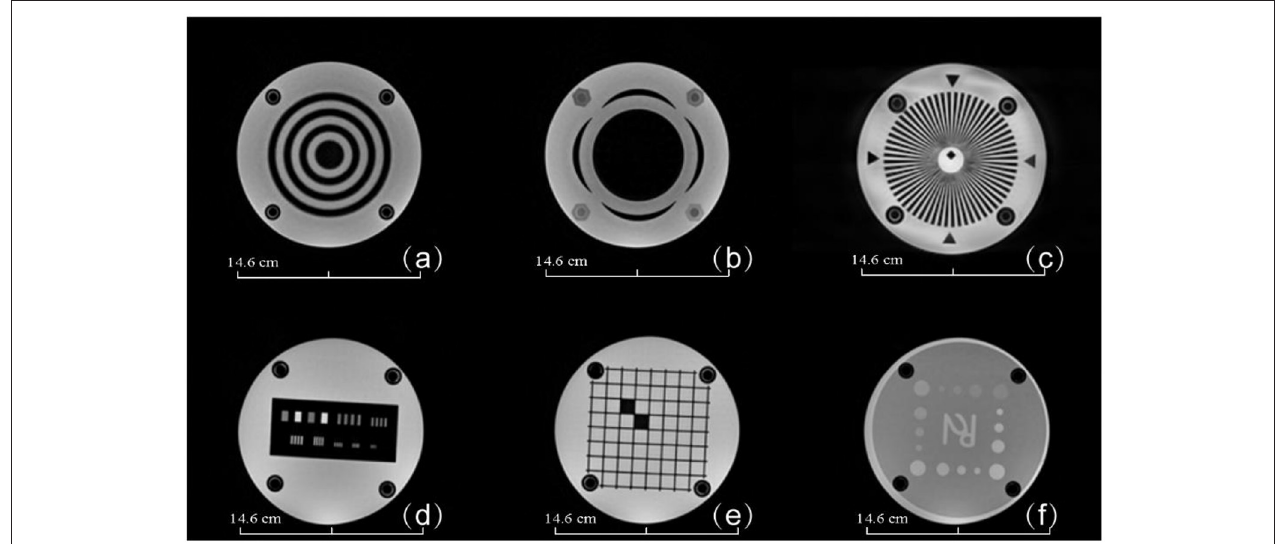
FIGURE 6 | MRI images of the 3D-printed MRI phantom. (a) Layer thickness module, (b) layer thickness module, (c) star MTF test module, (d) high contrast resolution test module, (e) geometric distortion test module, (f) low contrast test module. Phantom dimensions are marked in the figure.